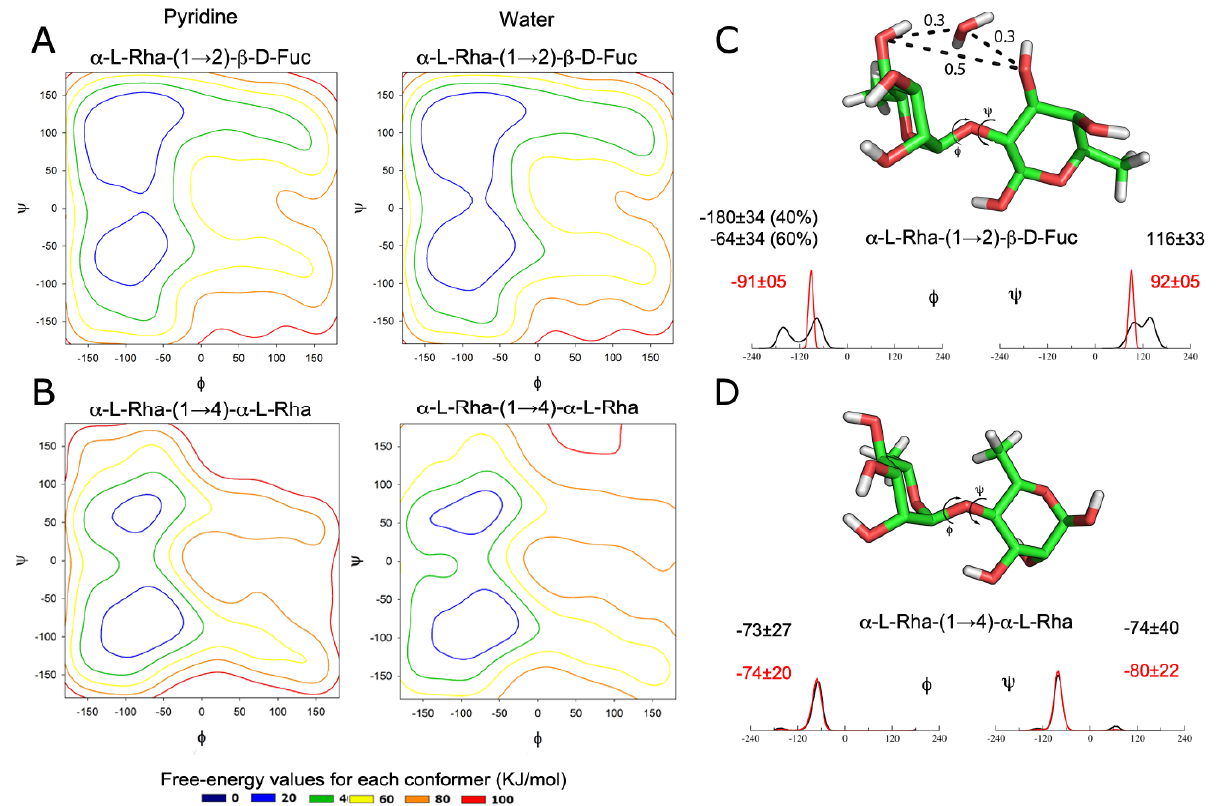
Figure 2. ( A , B ) Conformational behavior of α - L -Rha-(1 → 2)- β - D -Fuc and α - L -Rha-(1 → 4)- α - L -Rha linkages, as obtained from metadynamics in both pyridine and